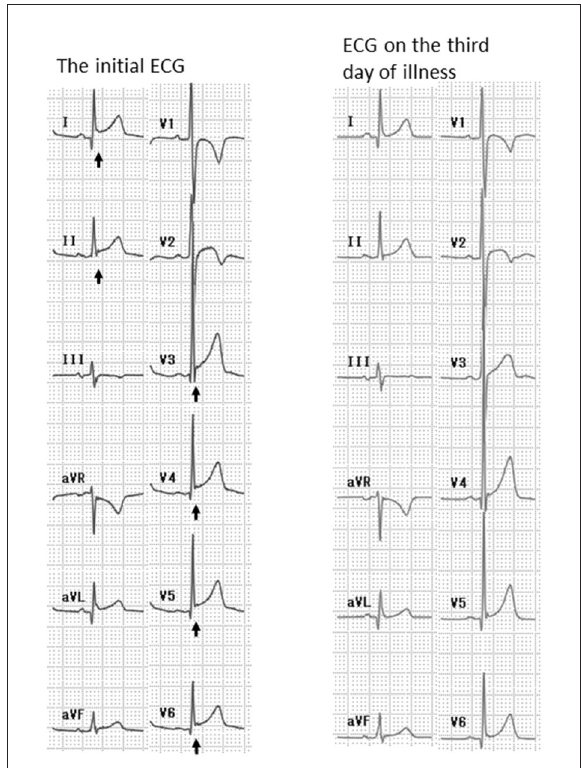
FIGURE1 Electrocardiogram (ECG) of Patient 5. The initial ECG showed ST-segment elevation in leads I, II, and V3–6 (arrows). The ECG on the third day of illness was